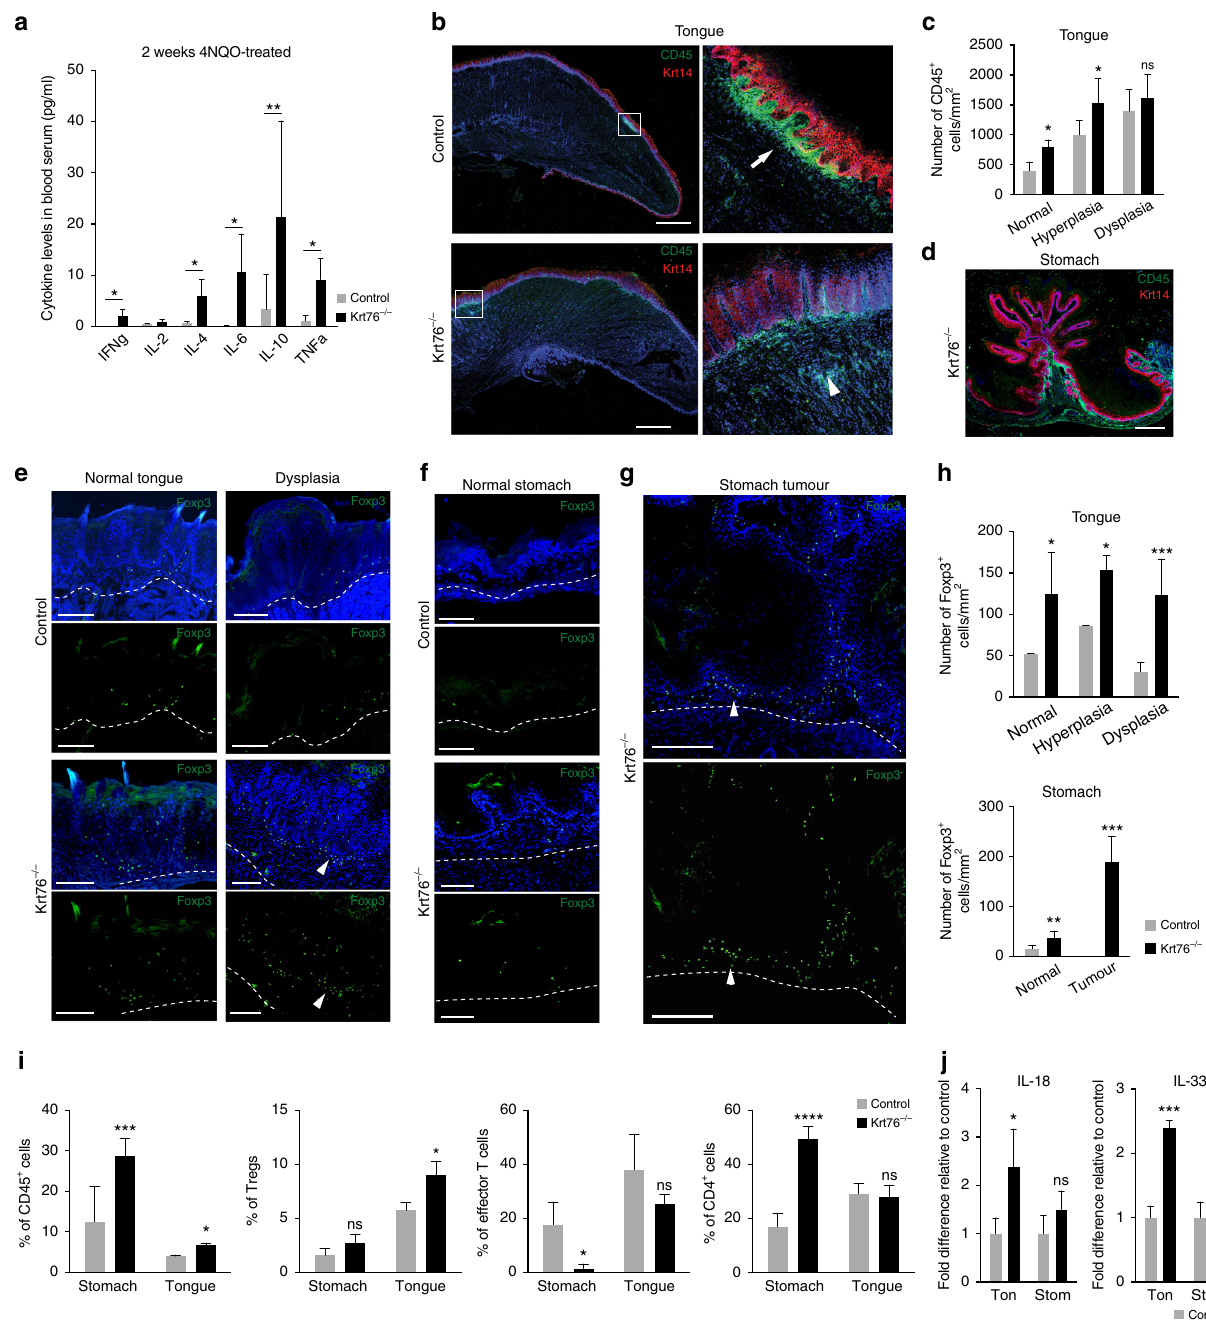
Fig. 6 In fi ltration of immune cell populations in tumour stroma. a Levels of cytokines in blood serum of control and Krt76 − / − mice after 2 weeks of 4NQO treatment, assessed by CBA analysis (means ± s.e.m., unpaired t -test, 4 mice per genotype, measured in duplicate, experiment repeated twice). b Representative images of CD45 and Keratin 14 immunostaining in tongue lesions treated with 4NQO. Arrow and arrowhead indicate local accumulations of CD45 + cells. c Quanti fi cation of in fi ltrating CD45 + leucocytes in 4NQO-treated tongue ( n = 3 – 8 mice/genotype, >4 microscopic views per region, means ± s.e.m., unpaired t -test). d Representative image of CD45 and Keratin 14 expression in stomach tumour. e Representative images of Foxp3 + Tregs in 4NQO-treated normal tongue (i.e., prior to development of hyperplasia) and dysplasias in control and Krt76 − / − mice. f , g Representative images of immunostaining of Foxp3 + Tregs in 4NQO-treated normal stomach ( f ) and tumours ( g ). e – g Dashed lines denote epithelial-stromal boundary; arrowheads denote FoxP3 + cells. h Quanti fi cation of in fi ltrating Foxp3 + Tregs in 4NQO-treated tongue and squamous stomach ( n = 3 – 8 mice per condition and per genotype,>4 microscopic views per region, means± s.e.m., unpaired t -test). i Summary of fl ow cytometric analysis of % CD45 + , CD4 + or effector T cells (CD4 + CD44 + CD62L low) cells in total live cells, and Foxp3 + Tregs in total CD4 + CD25 + T cells, in tongue and stomach epithelia after 4NQO treatment of control and Krt76 − / − mice ( n = 4 mice/genotype, means ± s.e.m., unpaired t -test). j Quantitative RT-PCR of IL-18 and IL-33 mRNAs in 4NQO-treated tongue and squamous stomach, normalised to glyceraldehyde 3-phosphate dehydrogenase ( n = 4 mice/genotype, means± s.e.m. of biological and technical triplicates; unpaired t -test). * p ≤ 0.05, ** p ≤ 0.01, *** p ≤ 0.001; **** p ≤ 0.0001; ns non-signi fi cant. Scale bars: 100 µ